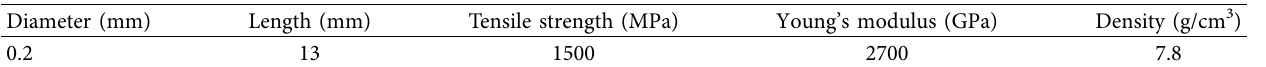
Table 6: Indexes of steel